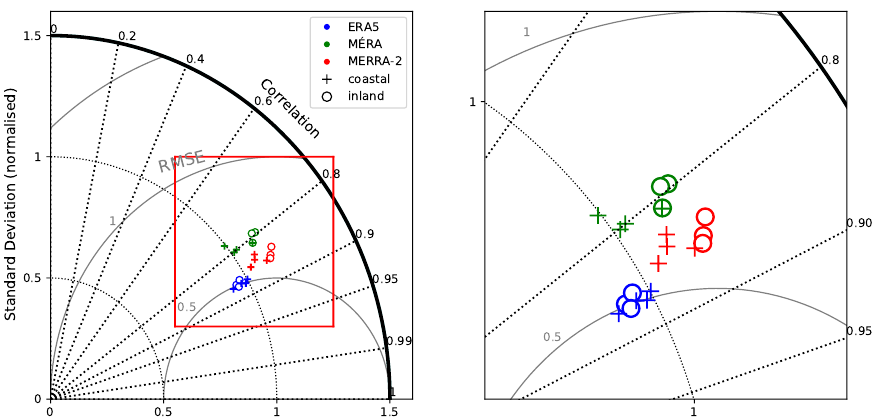
Figure 9. Left : Taylor diagram of SW in summer (JJA) for ERA5 ( blue ), MÉRA ( green ), and MERRA- 2 ( red ). The radial dimension represents the model normalised standard deviations, correlation coefficients are represented in angular coordinates, and the arcs show the normalised centred RMSE (CRMSE). Right : close-up view of the red box in left